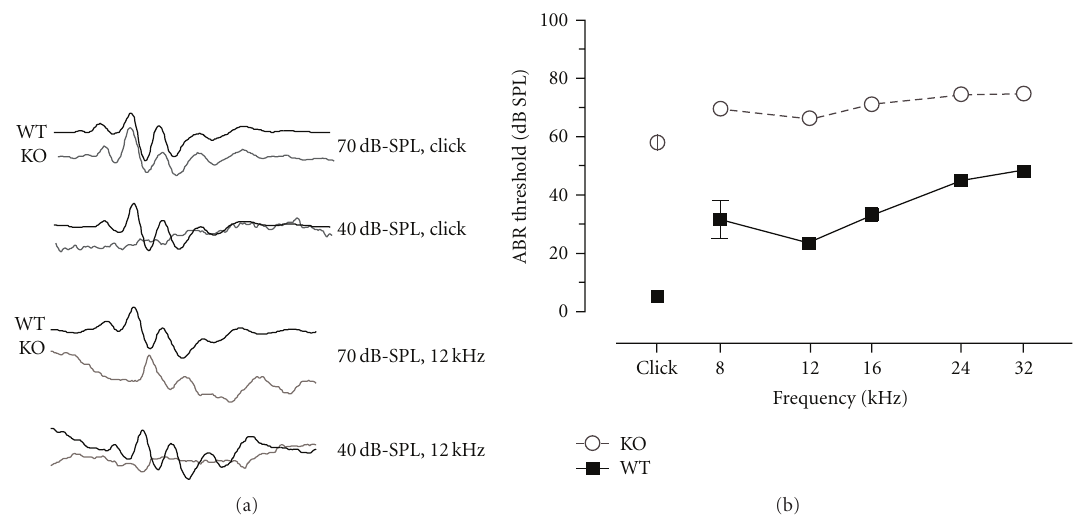
Figure 1: Prestin KO animals have increased ABR thresholds and severely impaired cochlear function. (a) ABR waveforms from WT and prestin KO animals. For 70dB-SPL stimuli the waveforms are similar in shape, and in both instances (click and 12kHz) the prestin-null animals have auditory-evoked responses above but not below 40 dB-SPL. (b) Cochlear function is severely impaired in the KO mice with an average threshold shift of ∼ 25–40dB at all frequencies